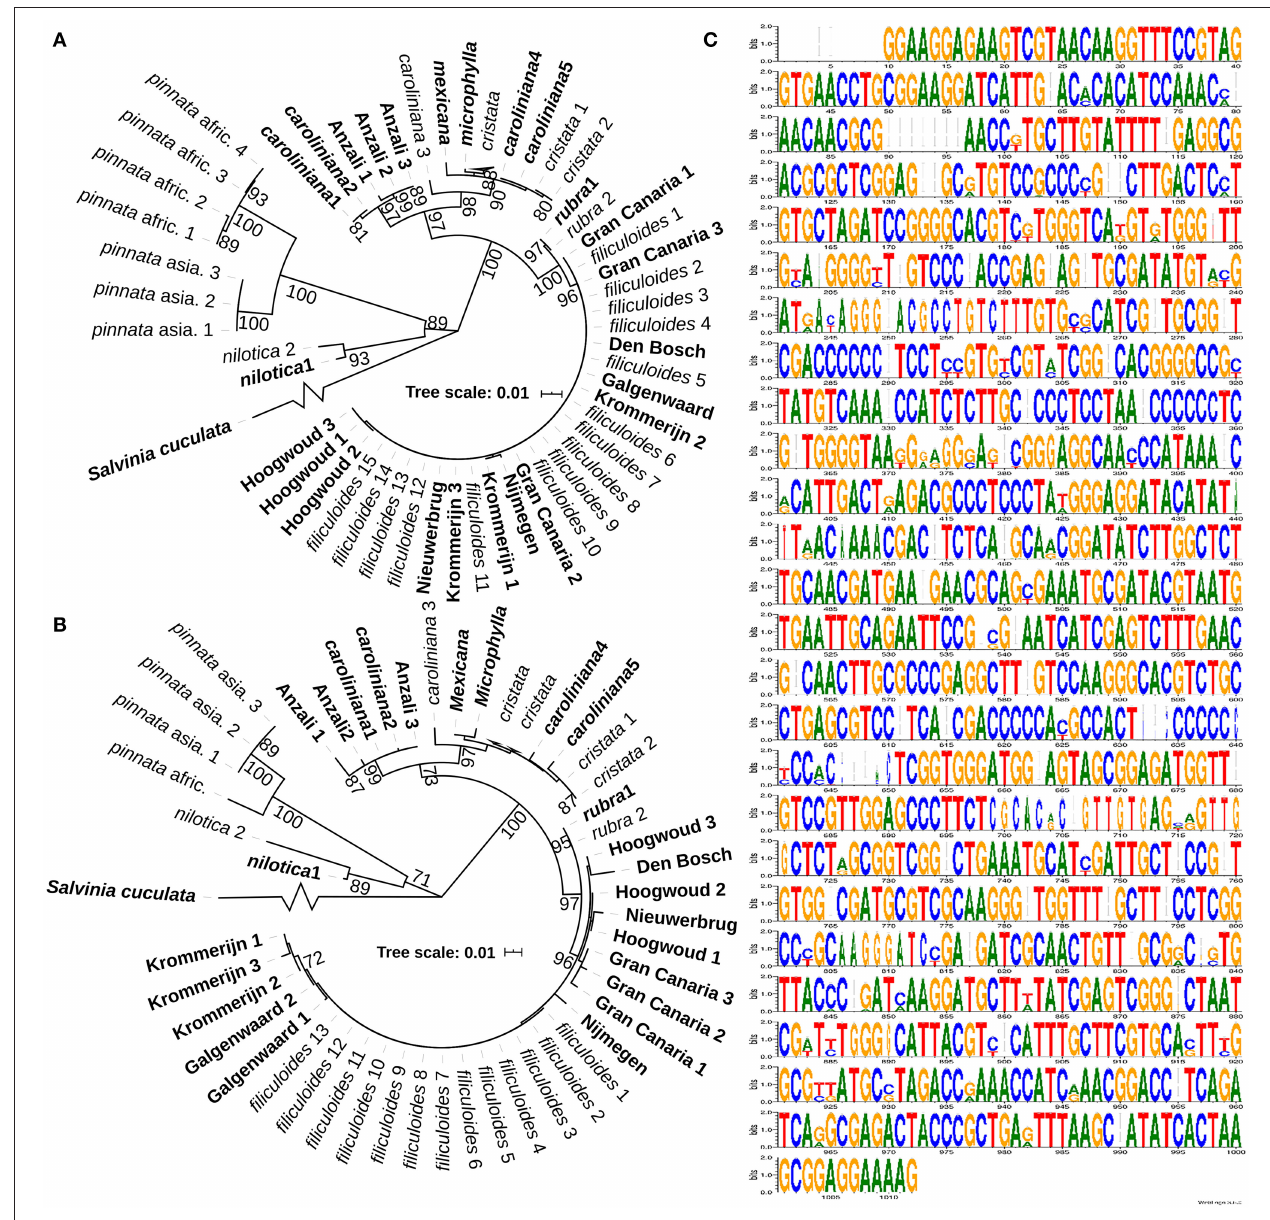
FIGURE 3 | Chloroplast marker regions in strains from the Netherlands, Spain, and Iran, and the ribosomal RNA (rRNA) intergenic regions of the A. filiculoides genome. (A) Phylogenetic tree of chloroplast regions trnL-trnF. The maximum likelihood (ML) trees were bootstrapped 1,000x. All bootstrap values > 0.70 are displayed. In bold: sequences from accessions in this study labeled after their collection site and sequences from the differing species extracted from genome shot-gun sequencing (Li et al., 2018). In regular type: sequences from the Madeira et al. (2016) study. (B) Phylogenetic tree of chloroplast regions trnG-trnR. (C) Sequence logo of all ITS1 gene regions in the A. filiculoides genome (Li et al., 2018). The gene regions were extracted and aligned (MEGA 7) and then used for in silico PCR. The results were visualized using WebLogo (vs. 2.8.2 Crooks et al., 2014): at each position of the ITS, the height of the stack indicates the sequence conservation, whereas the height of symbols within the stack indicates the relative frequency of each